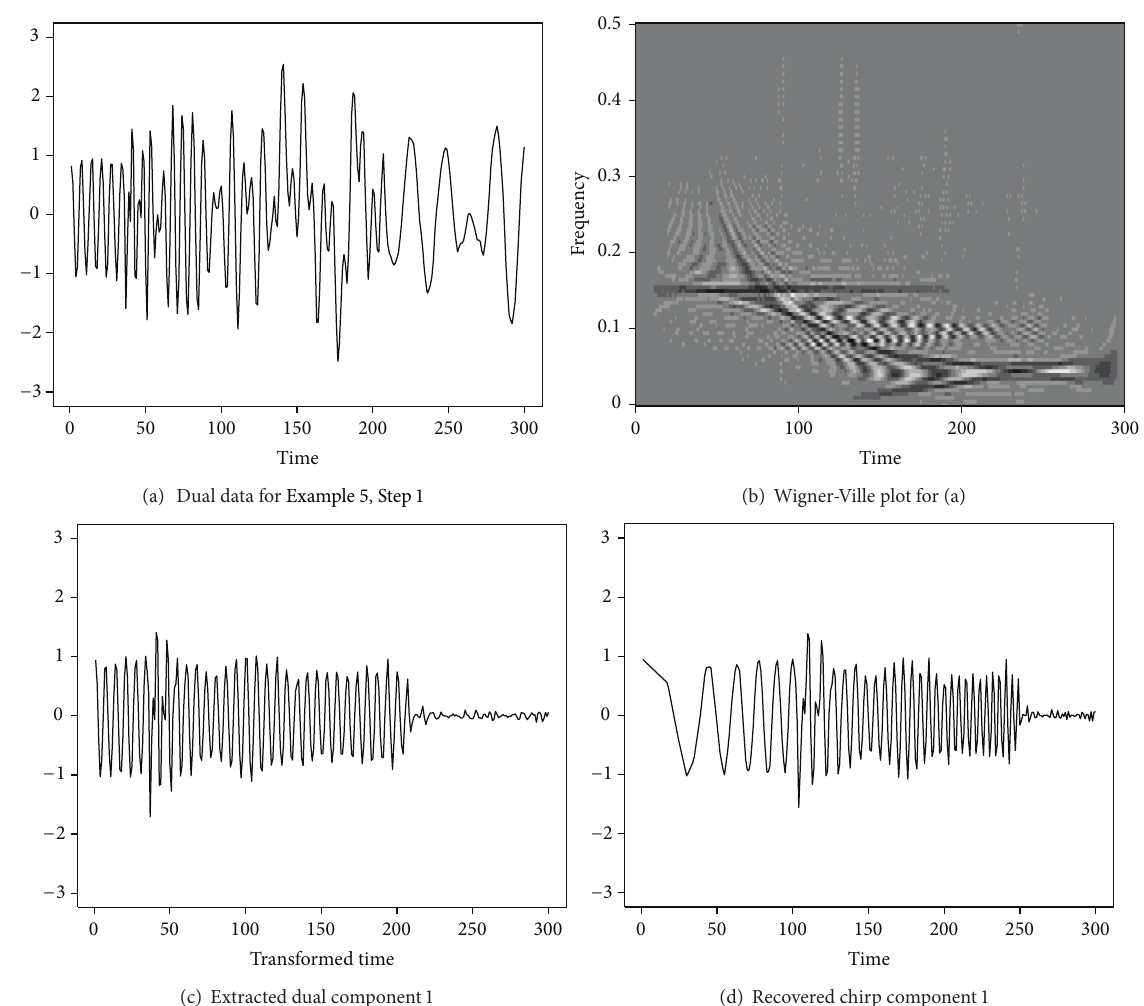
Figure 9: (a) The dual data (1:300) after the first time deformation; (b) the Wigner-Ville time-frequency distribution of the dual; (c) the extracted stationary dual component; (d) the recovered first linear chirp